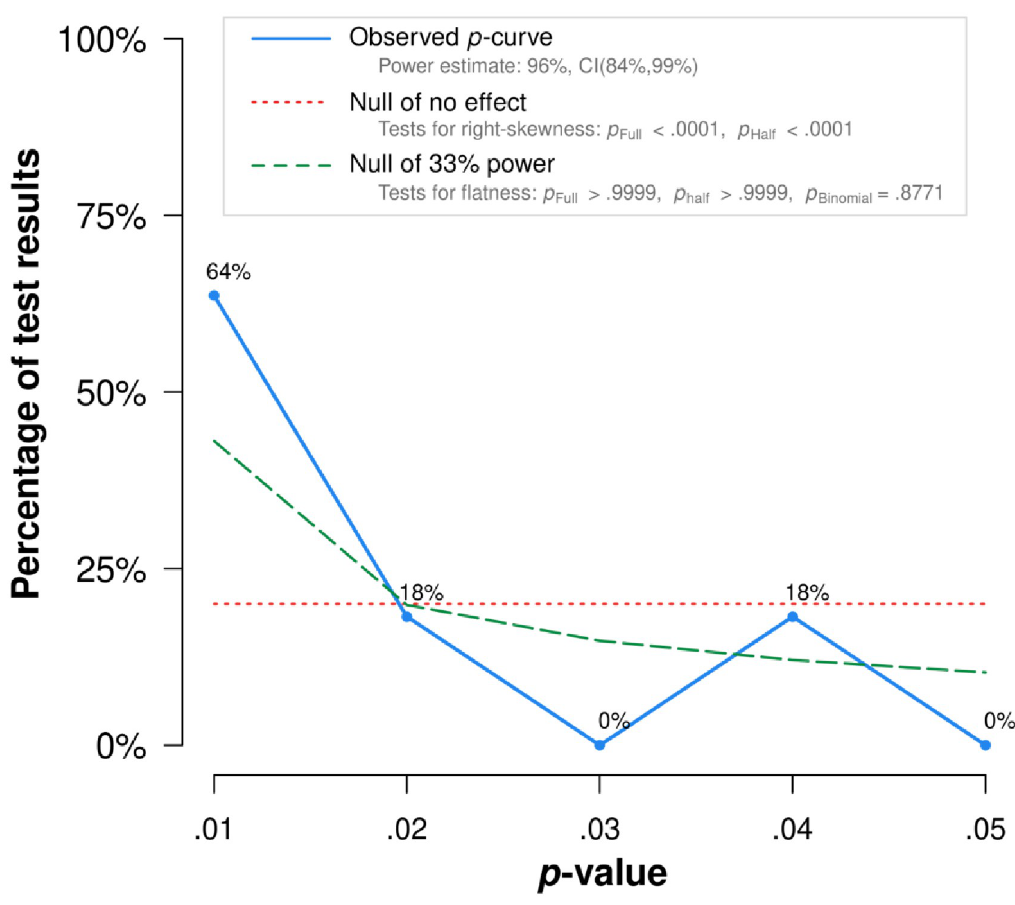
Fig 4. P -curve plot for studies on positive affect and alcohol consumption. Note: The observed p -curve includes 11 statistically significant ( p < .05) results, of which 9 are p < .025. There were 39 additional results entered but excluded from p - curve because they were p >